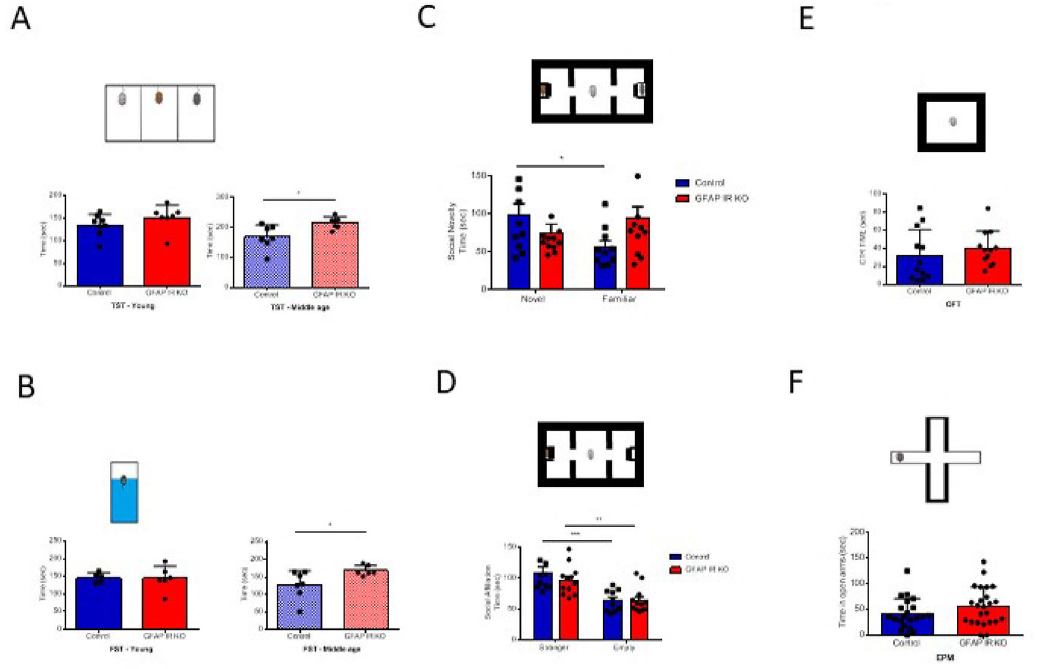
Figure 1. Mood traits in micelacking insulinreceptors (IR)in GFAP astrocytes (GFAP-IR KO mice). A,Adult (right histograms, control n= 6, GFAP IR KO n=7, t-test, t= 2.54; *p<0.05), but not young (left histograms, control n= 8, GFAP IR KO n=7, t-test, t= 1.26, p=0.22) GFAP IR KO mice show increased immobilization time in the tail suspension test (upperdrawing),anindicatorofadepressive-likebehaviorandreducedresiliencetostress.B,Similarly,intheforced swim test (upper drawing), adult (right histograms, control n= 5, GFAP IR KO n=6, t-test, t= 2.5; *p<0.05, Welch`s correction), but not young (left histograms, control n= 5, GFAP IR KO n=6, t-test, t= 0.10; p=0.922) GFAP IR KO mice show increased depressive-like performance, with less time spent swimming. C, Social novelty, as measured by time